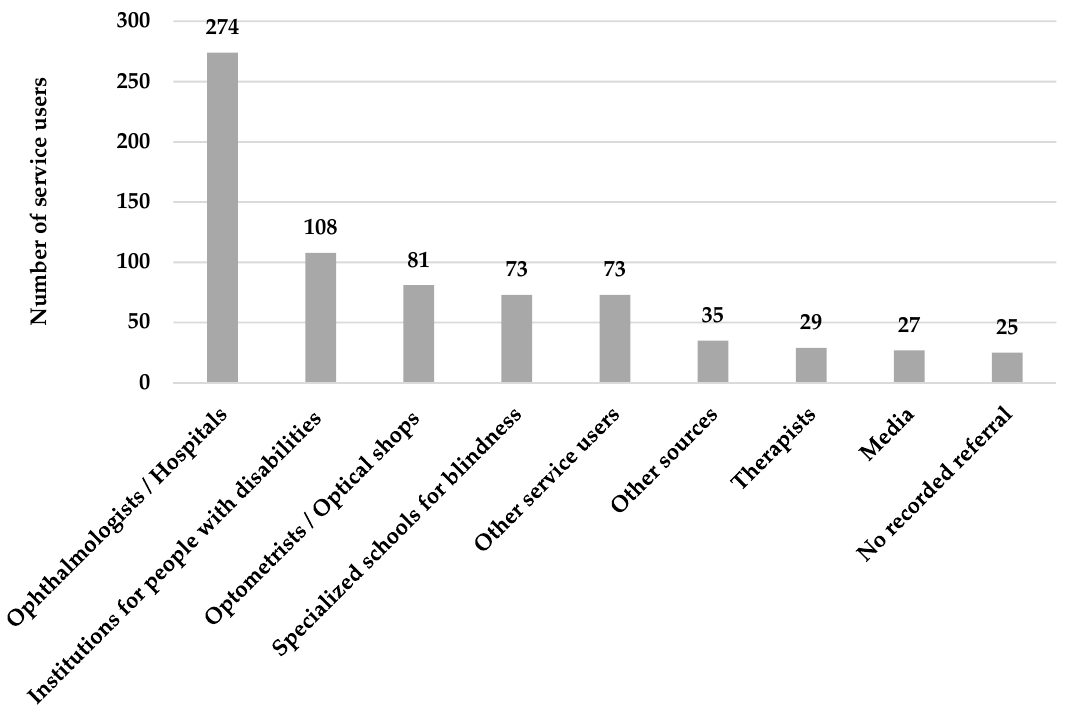
Figure 2. Referral sources of service users.